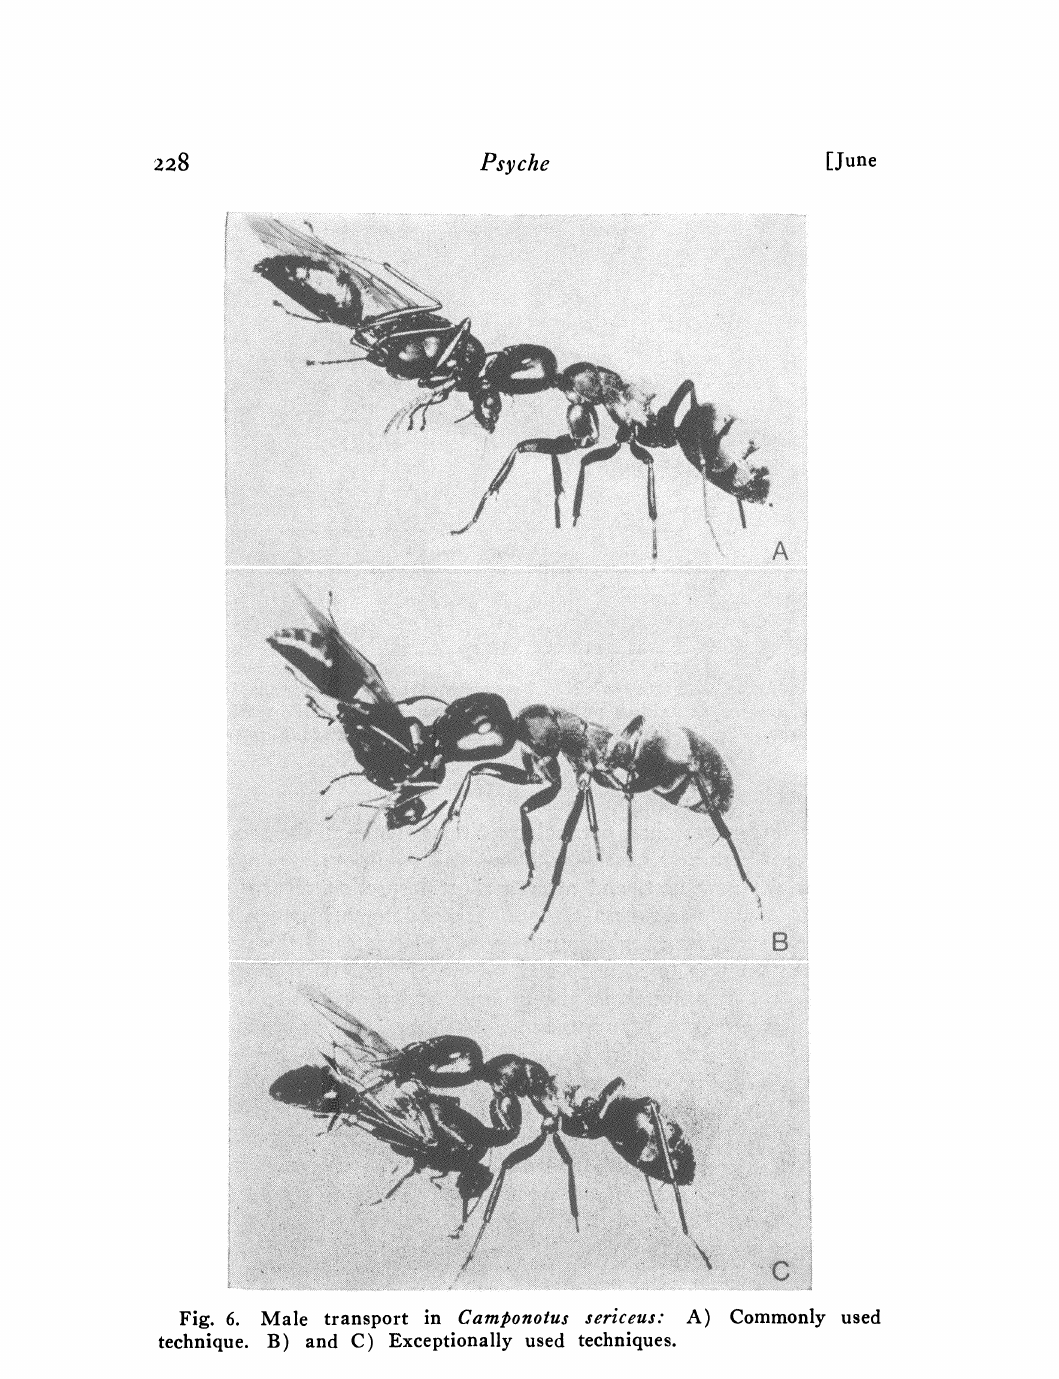
Fig. 6. Male transport in Camlonotus sericeus: A) Commonly used technique. B) and C) Exceptionally used